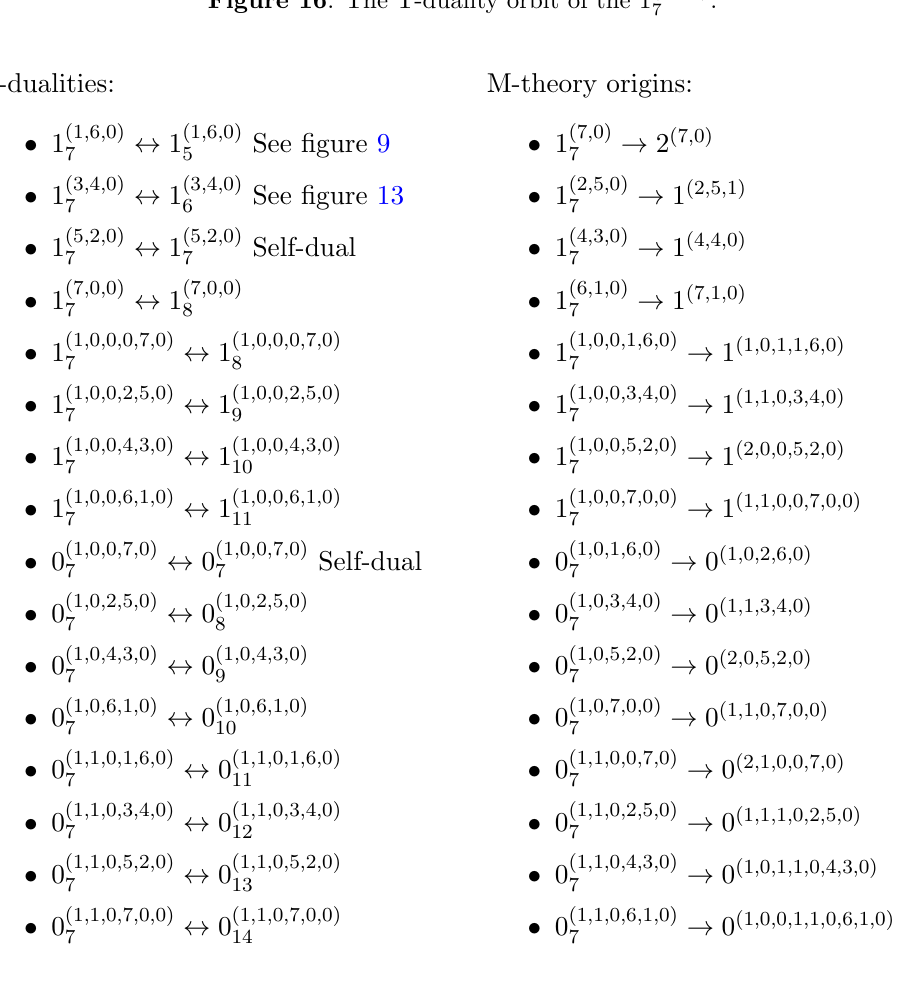
Figure 16 . The T-duality orbit of the 1 (1 ; 6 ; 0)